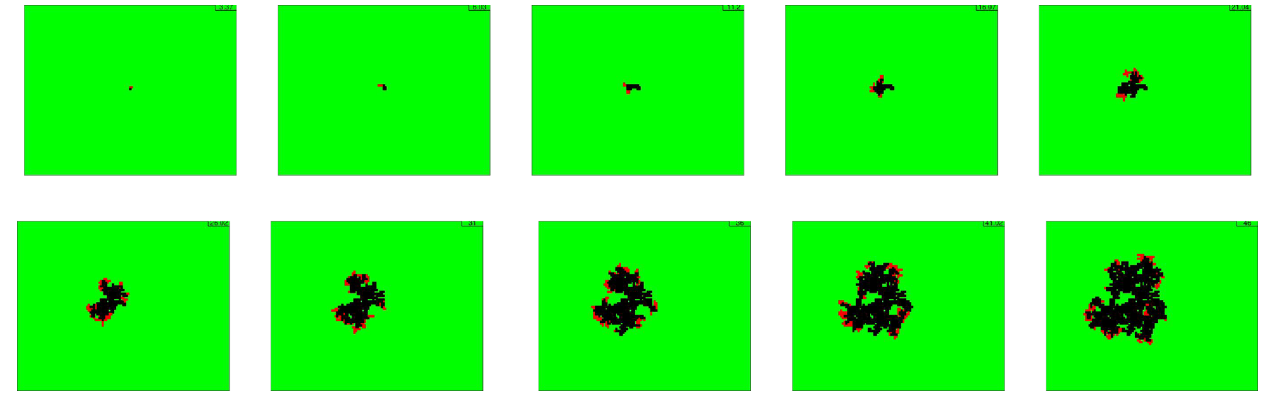
Figure 4. A second simulation run of the model fit to the observed data from Figs. 1 and 2.